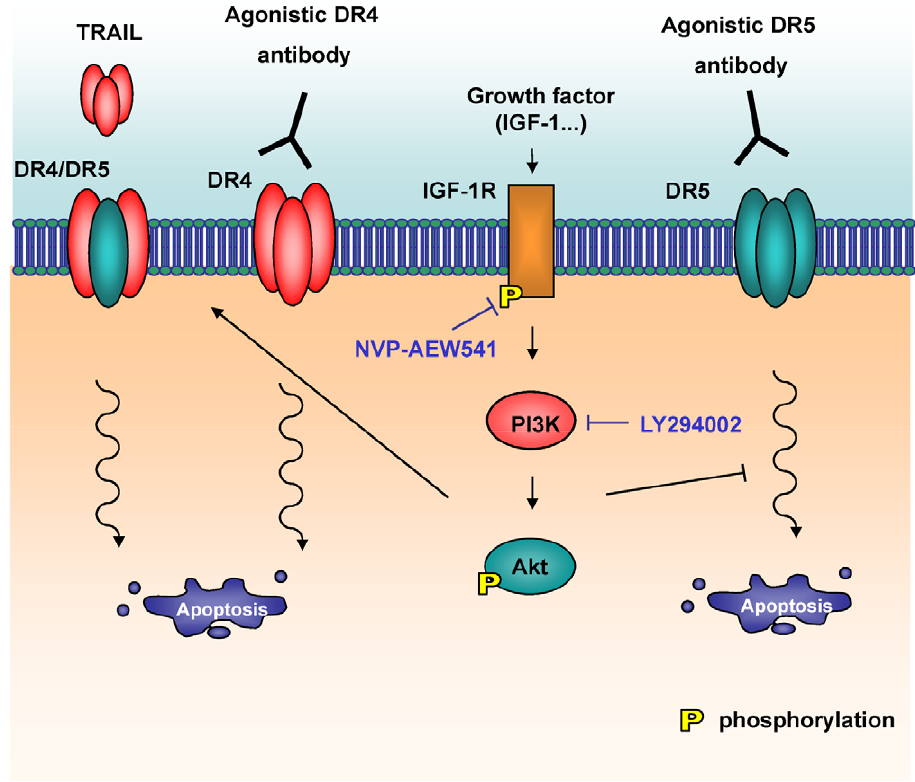
Fig. 6. Model for differential modulation of TRAIL receptor ligand-induced apoptosis by IGF-1R/I3K-dependent mechanisms. TRAIL recep- tor-specific agonists bind to their cognate TRAIL death receptor trimers, stimulating the TRAIL receptor-mediated apoptosic pathway. In this figure, DR4 and DR5 specifically designate homotrimers, while DR4/DR5 refers to either type of trimer, including possible heterotrimers. Upon activation of IGF-1R by growth factors such as IGF-1, the receptor becomes autophosphorylated, which activates PI3K. Active PI3K triggers Akt phosphorylation and its subsequent activation. Inhibition of PI3K using LY294002 or inhibition of IGF-1R-induced PI3K activation us- ing NVP-AEW541 leads to a decrease in Akt phosphorylation. This is also accompanied by inhibition of TRAIL- and agonistic DR4 anti- body-induced apoptosis, notably due to a decrease in membrane DR4 expression and decreased caspase 8 cleavage. Conversely, caspase 8 cleav- age and apoptosis induced by agonistic DR5 antibody are increased when IGF-1R or PI3K are inhibited using NVP-AEW541 or LY294002, respectively. (Colors are visible in the online version of the article;